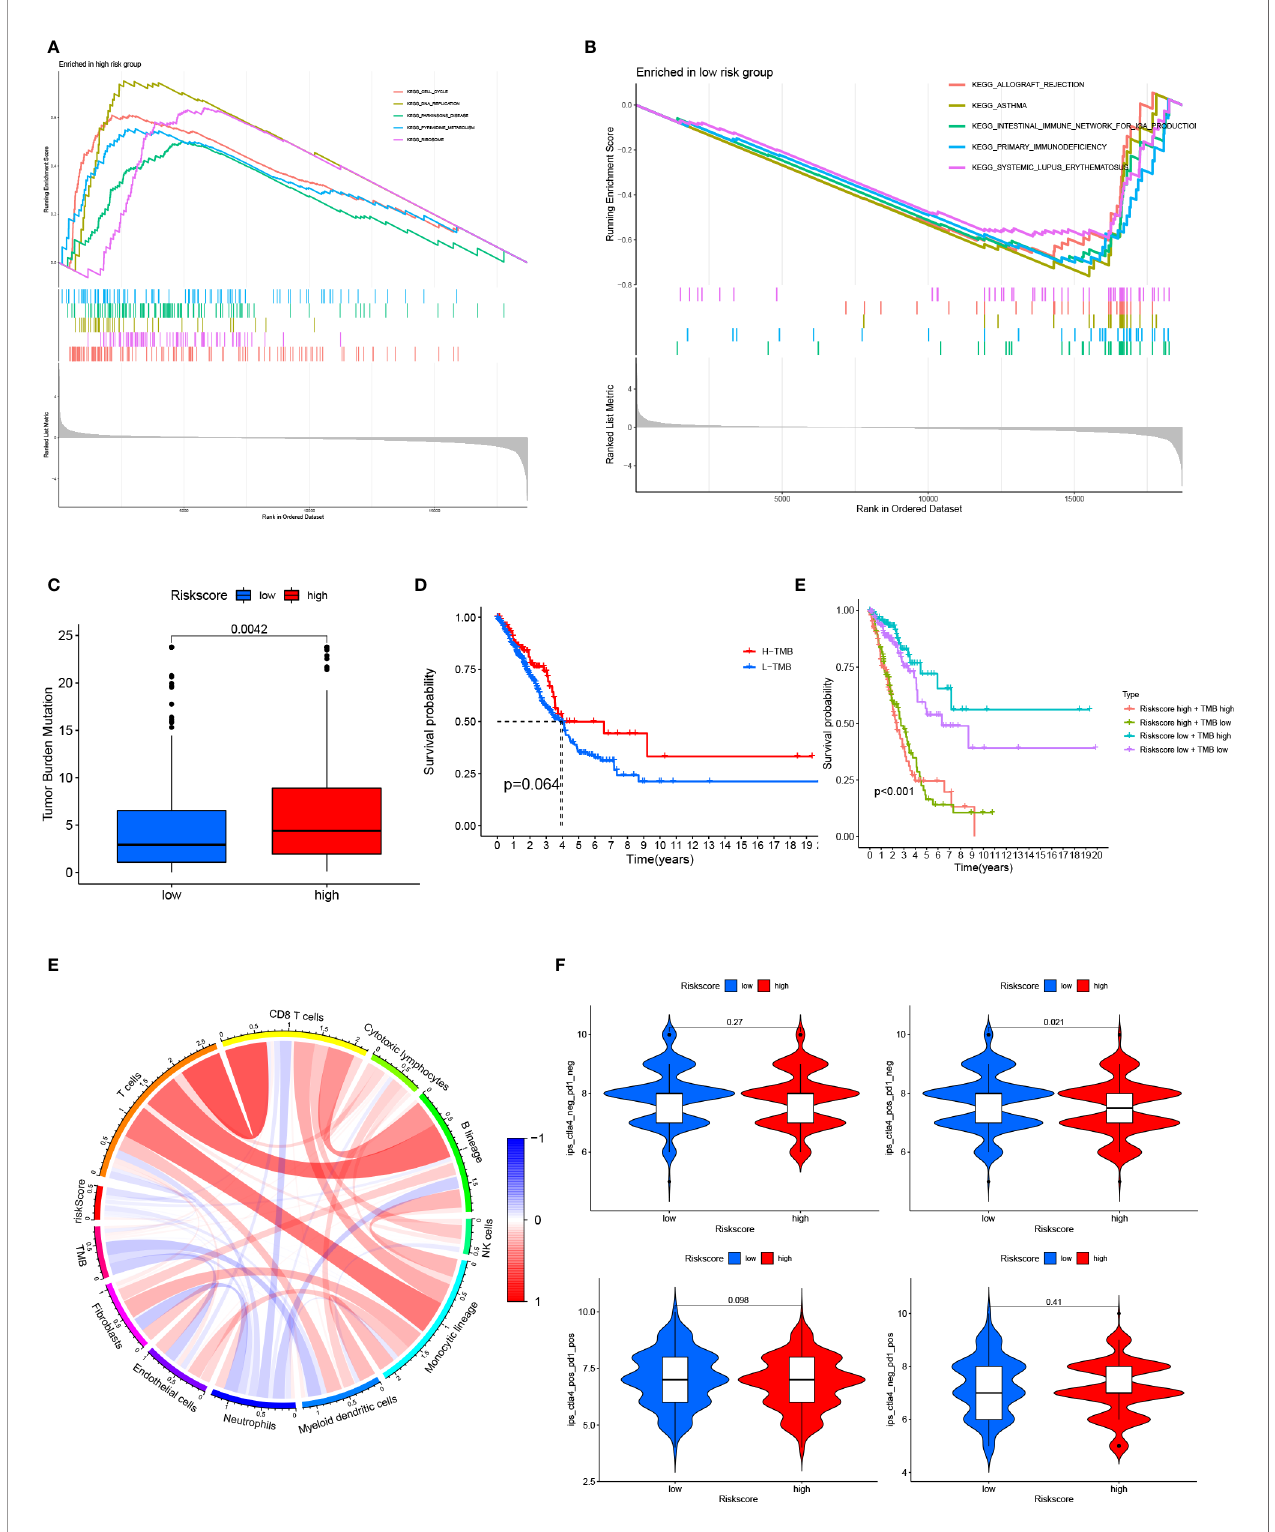
FIGURE 6 | Relationship between the 15-gene risk signature, TMB, and the IPS (A, B) GSEA for patients in the high- and low-risk groups; (C) TMB in patients in the high- and low-risk groups; (D) Kaplan – Meier survival curves showed no signi fi cant difference in OS between patients in the high-TMB group and low-TMB group; (E) Kaplan – Meier survival curves combining the risk score and TMB; (F) Relationship between the 15-gene risk signature, TMB, and immune cells; (G) , Relationship between the 15-gene risk signature and the IPS. ROC, receiver operating characteristic; LUAD, lung adenocarcinoma; IPS, immunophenoscore; TMB, tumor mutation burden; OS, overall